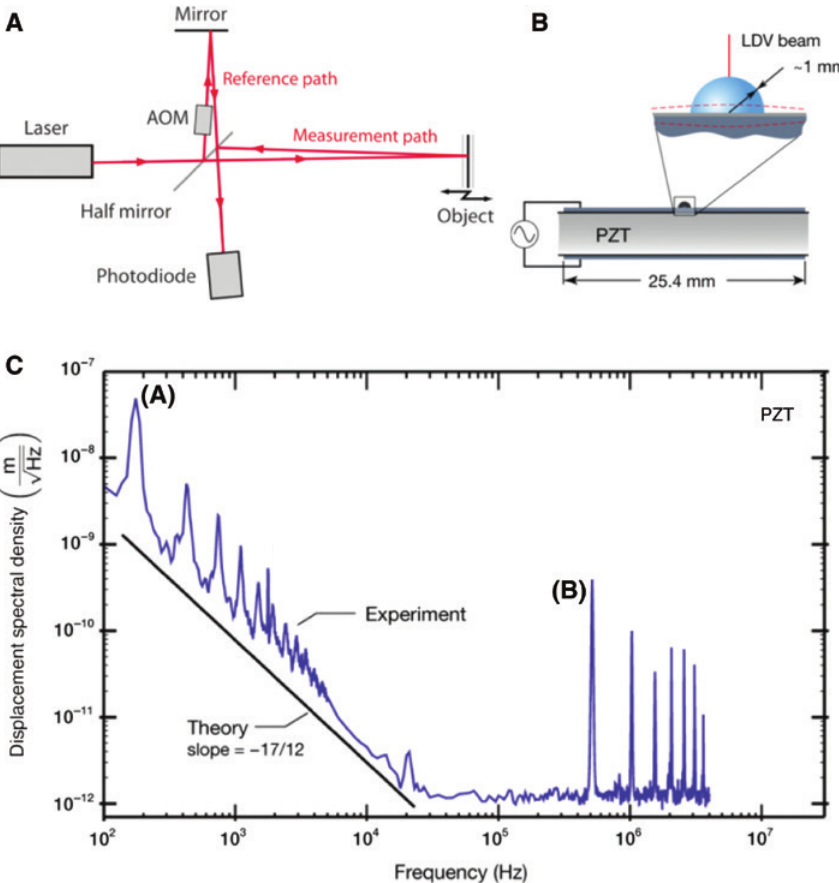
Figure 8: Liquid droplets and laser Doppler